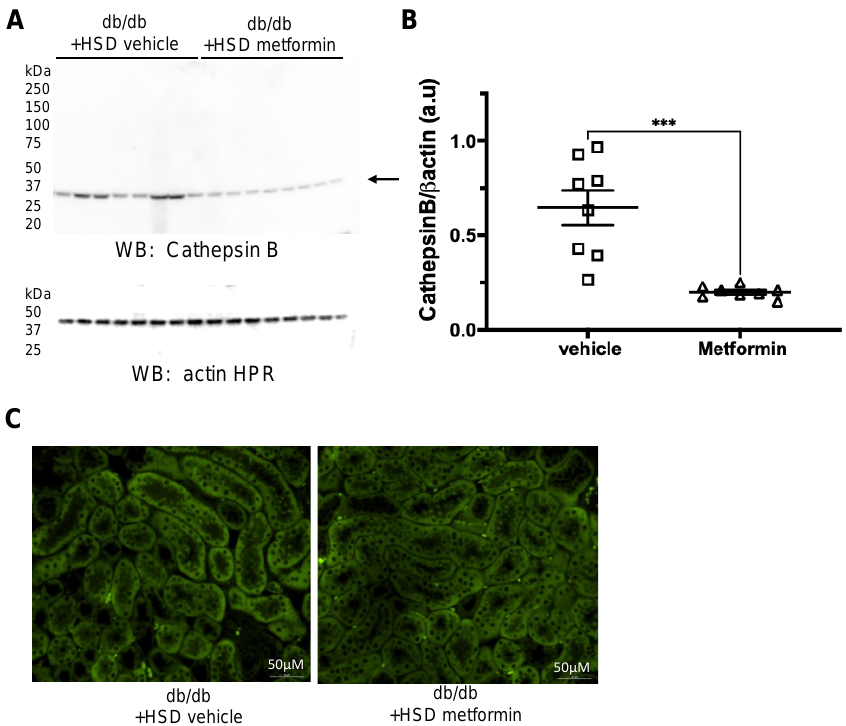
Figure 4. Renal expression of cathepsin B protein is attenuated by metformin treatment. ( A ) Western blot for cathepsin B protein expression in kidney cortex lysates from vehicle-treated or metformin- treated diabetic db/db mice maintained on an HSD. ( B ) Densitometric analysis of the immunoreactive band in panel A normalized to actin ( C ) Immunohistochemistry showing cathepsin B protein expres- sion in the kidneys of hypertensive diabetic db/db mice treated with vehicle or metformin. N = 8. Data are plotted as mean ± SEM, *** represents a p -value < 0.001, and a.u. represents arbitrary